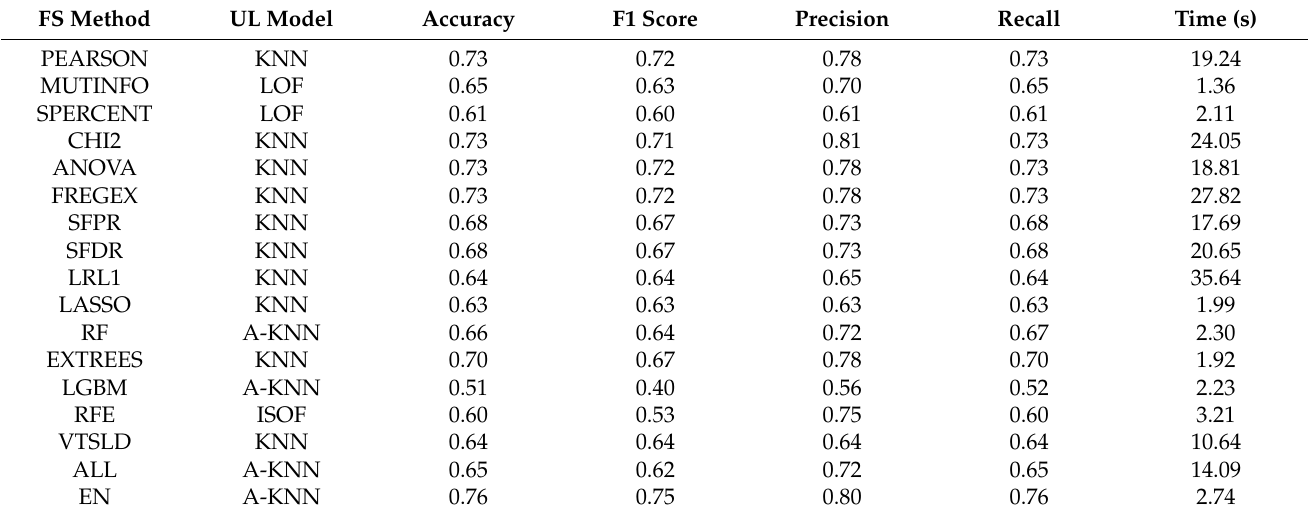
Table 11. Individual FS method best performance summary for unsupervised learning.